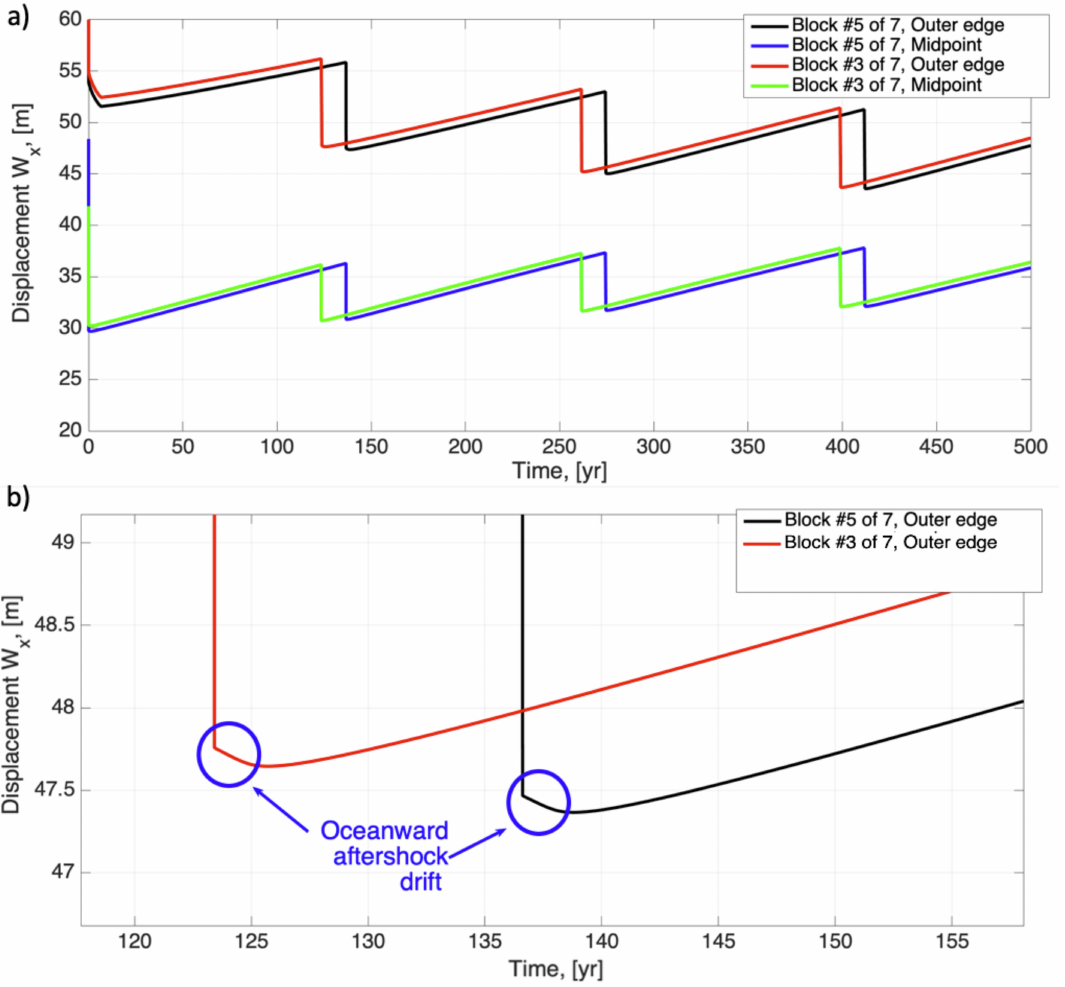
Figure 3. Displacement variations W ( x , t ), simulated with an original single-segment model for an outer edge and midpoint of blocks. Panel ( a ) shows an overall cycle pattern for 2 different blocks (assuming 7-block structure), while panel ( b ) provides a detailed picture showing the postseismic oceanward motion, observed at the outer region of the